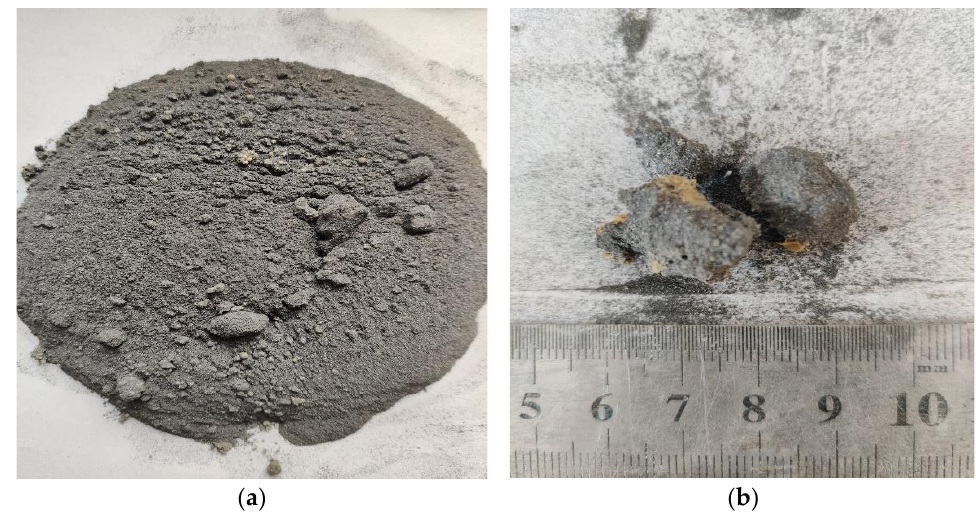
Figure 3. ( a ) The appearance of HCFARA; ( b ) Sintered particles in the HCFARA.